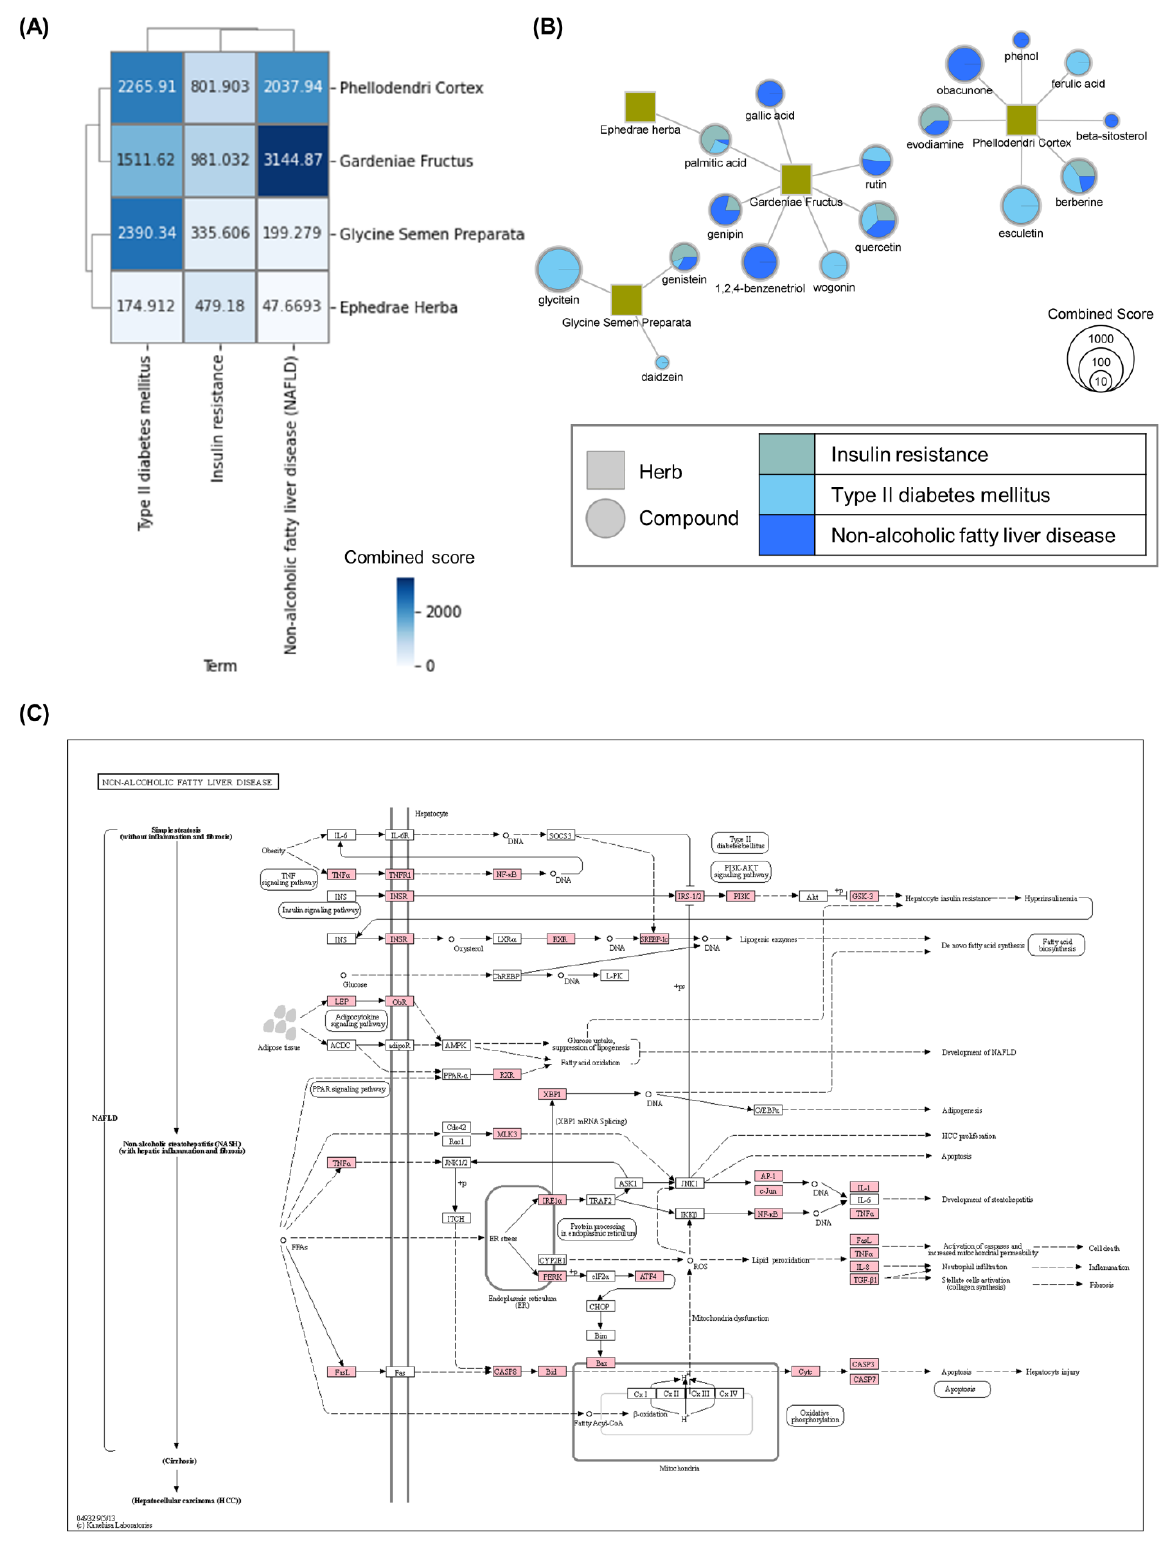
Figure 3. Association between herbs in AMGB and pathways related with complications resulting from obesity. ( A ) Cluster heatmap of combined scores of herbs. ( B ) Herb–compound network of AMGB, focusing on the association between compounds and pathways. ( C ) Pathway of non-alcoholic fatty liver disease and predicted targets of AMGB, visualized by KEGG mapper. Boxes represent proteins that compose the pathway. The pink-colored boxes represent predicted targets of AMGB. All the details are the same as in Figure